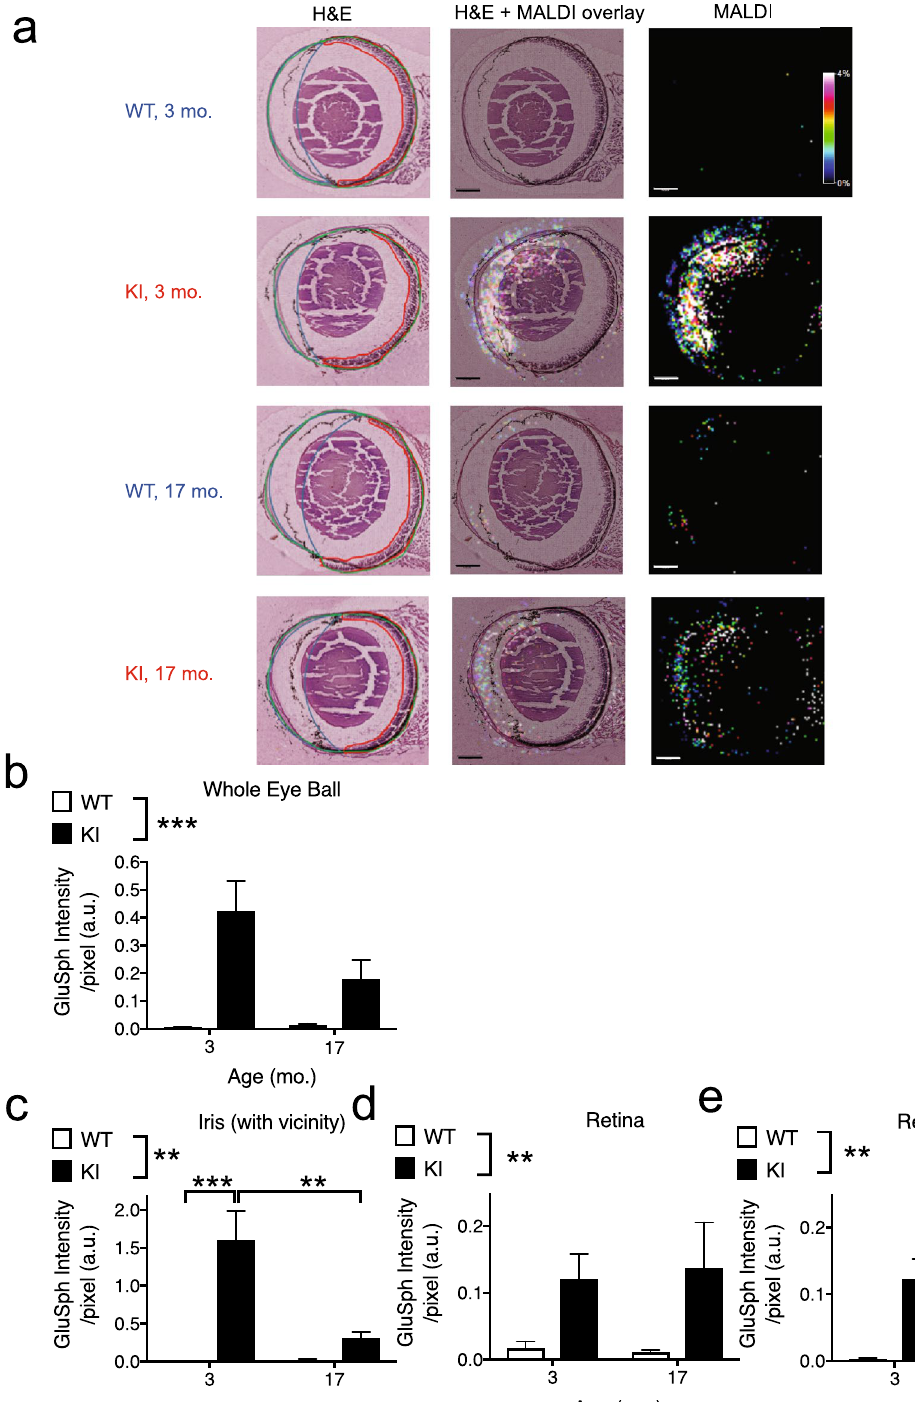
Figure 7. MALDI imaging reveals increased GluSph levels in ocular tissues in Gba KI mice. ( a ) The left column shows representative images of H & E sections with an ROI for the entire eyeball (outlined in green). Sub-ROIs within the eye ball included the iris and its vicinity (outlined in blue), the retina (outlined in red), as well as a calculated, residual ROI within the eyeball excluding the other ROIs. The residual ROI mainly corresponds to the lens and the posterior chamber. H & E and MALDI images of GluSph (middle column), and MALDI images of GluSph (right column) are also shown. The scale bar denotes 500 µm. The color scale represents GluSph signal intensity. Quantification of the GluSph levels of the entire eyeball ( b ), the iris ( c ), the retina ( d ), and the ROI of the residual ROI within the eye ball ( e ). Asterisks denoting significance levels for main effects of genotype are indicated next to the genotype symbols above the graphs; those for post-hoc tests between individual genotype- and age-combinations are indicated within the graphs. Main effects of age are not indicated. ** p < 0.01, *** p < 0.001. Values are mean ±